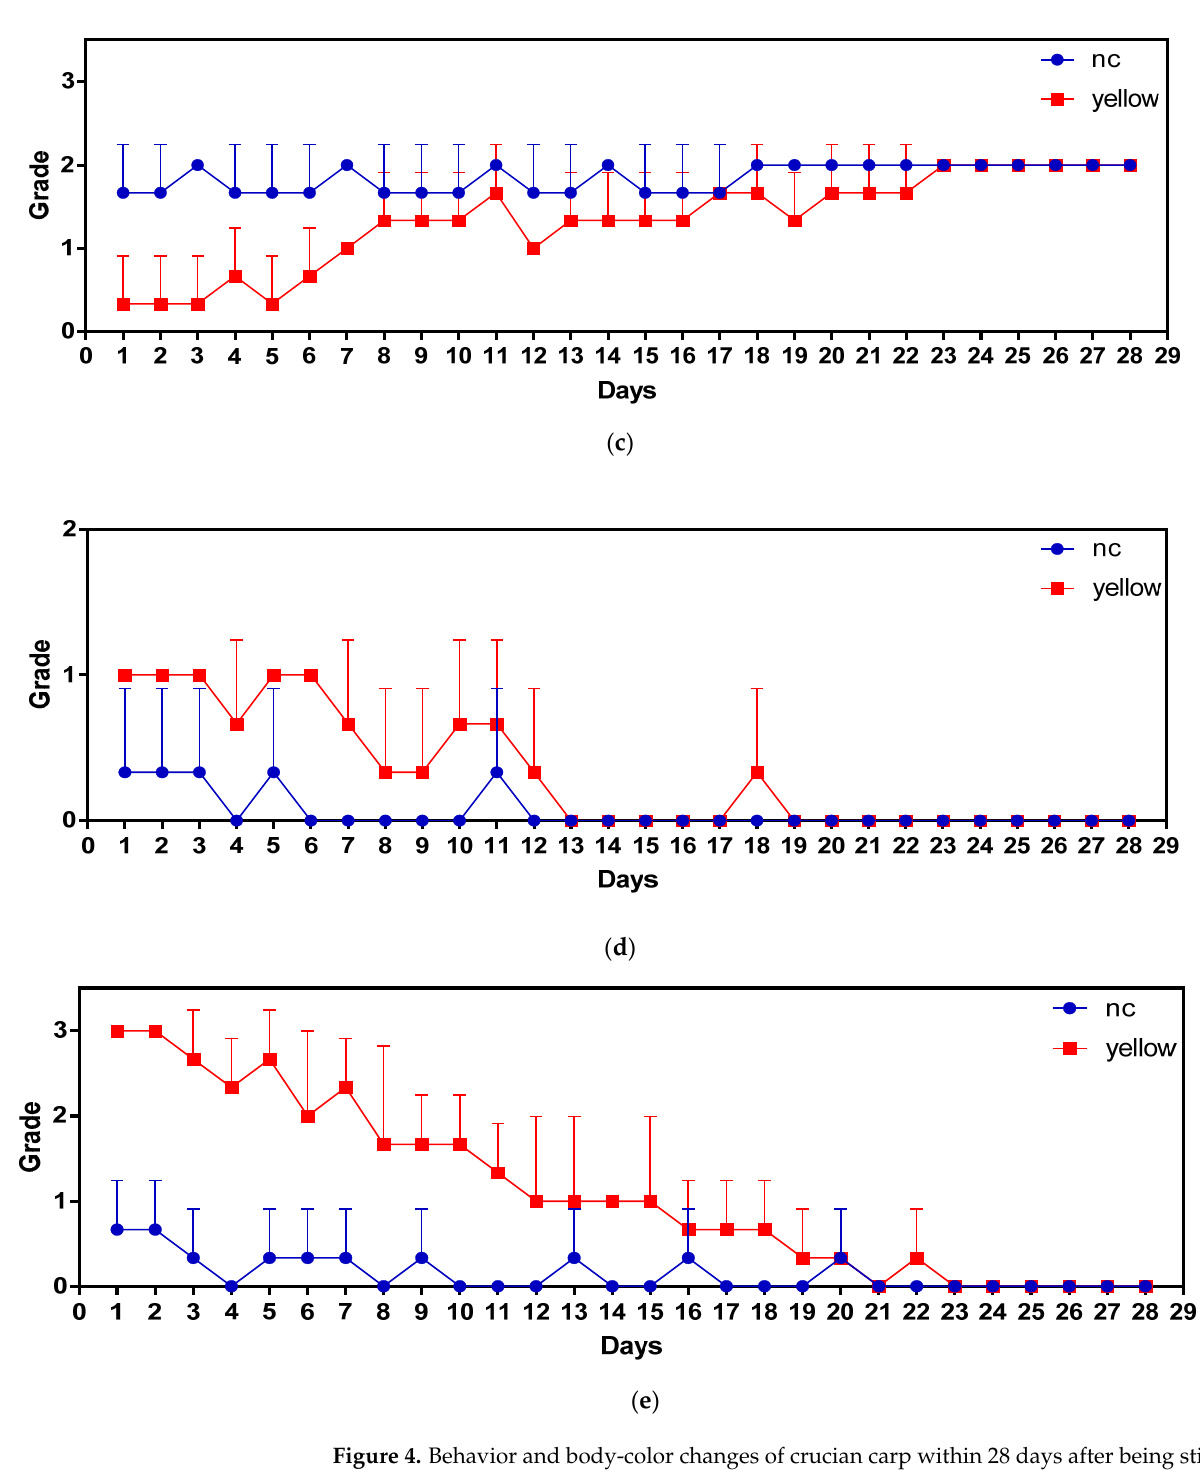
Figure 4. Behavior and body-color changes of crucian carp within 28 days after being stimulated by the bionic robot fish. ( a ) Regional location; ( b ) Behavioral activity; ( c ) Location in the water body; ( d ) Abnormal movement; ( e ) Body color. Values are represented as mean ± SD of data from triplicates per treatment ( n = 5).